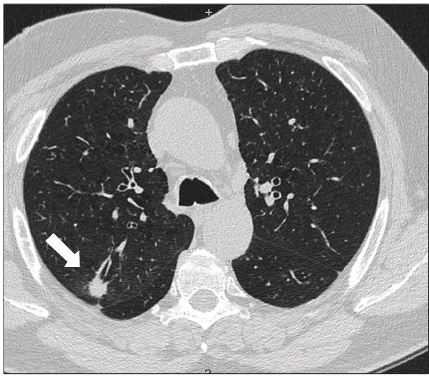
Figure 1: Accidental nodule of the right pulmonary upper lobe (arrow).